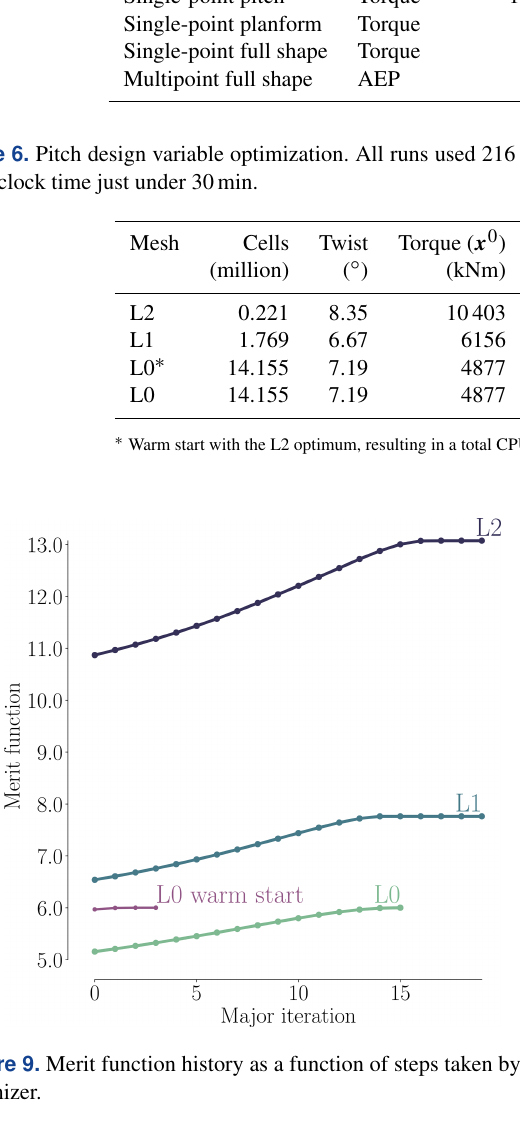
Design variables